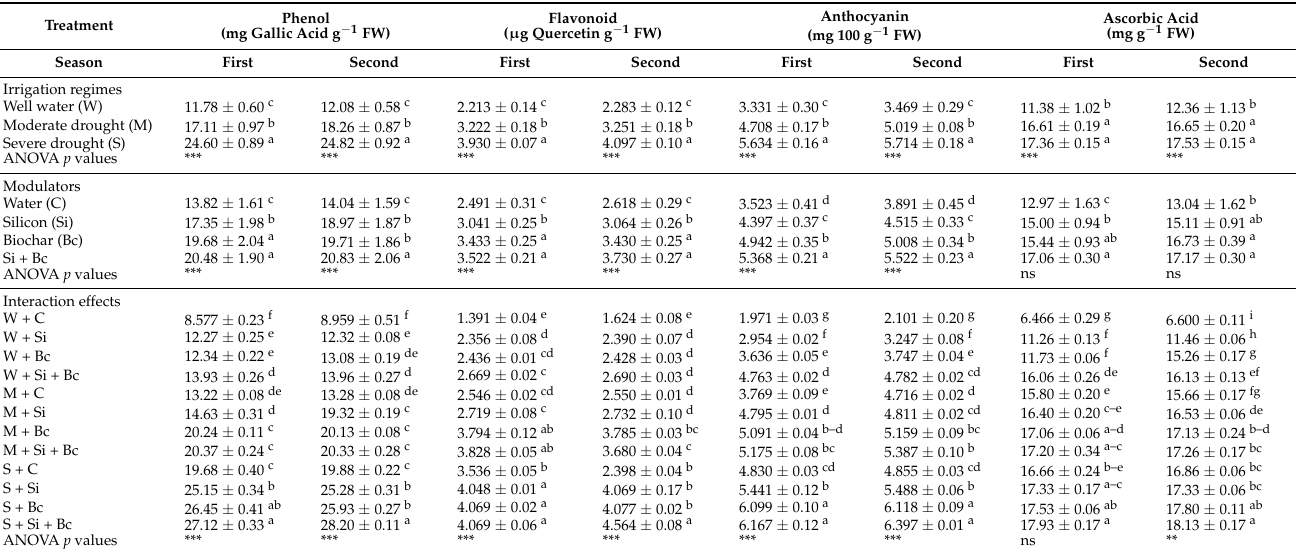
Table 3. Effect of irrigation regimes, silicon, biochar and their interaction on antioxidant solute concentrations of borage plants throughout two experimental